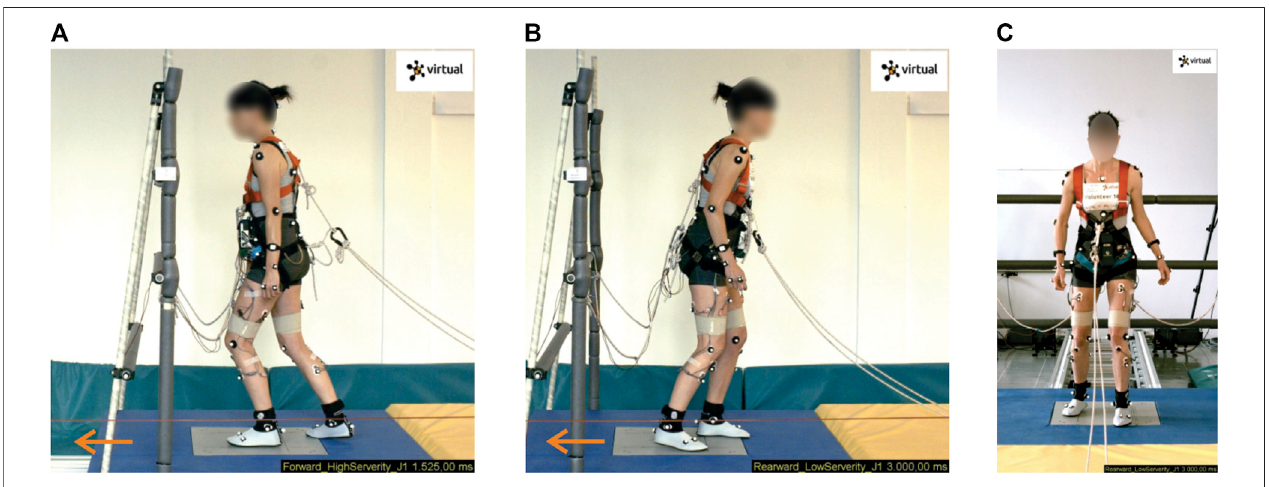
FIGURE 2 | Forward and backward orientation of the volunteers studied in the sled tests. The moving platform induced backward stepping when the volunteers were facing forwards (A) , and forward stepping when facing backwards (B, C) . The volunteer depicted (Volunteer 16) shows a typical kinematic response during the stepping strategy.